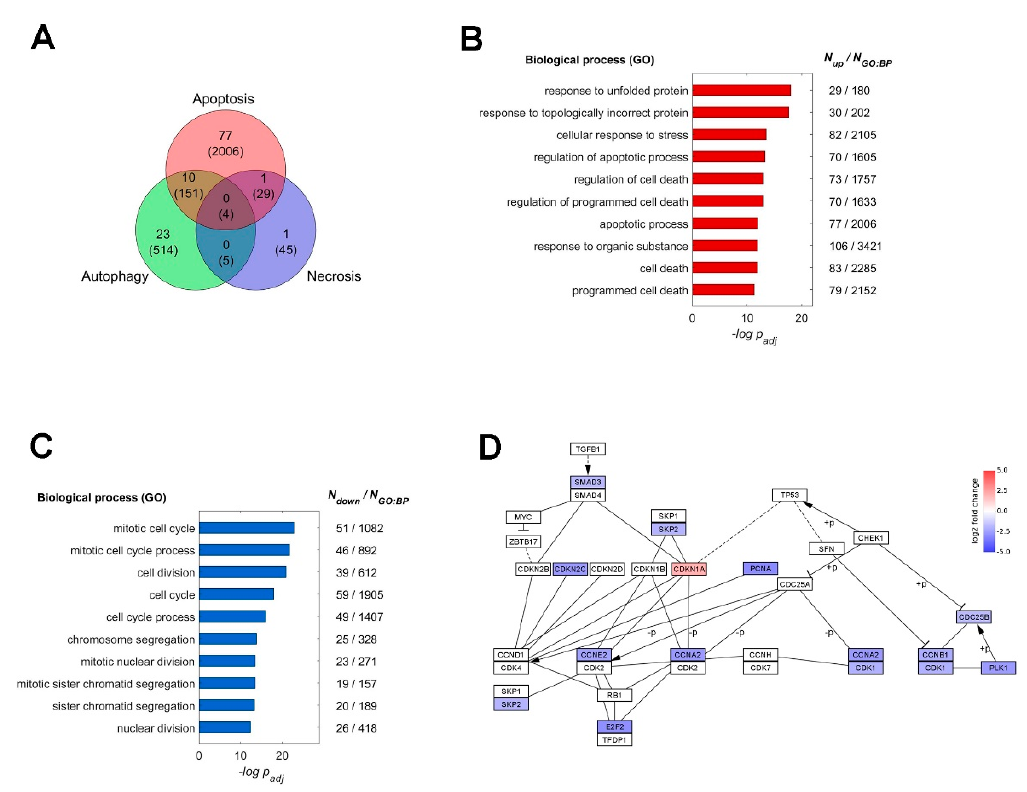
Figure 9. The altered expression profile upon the CD treatment. ( A ) The number of up-regulated genes are depicted in the Venn diagram showing their roles in types of programmed cell death. The intersection areas indicate the number of genes participating in multiple processes. The total number of genes in each category is indicated in parentheses. The top 10 enriched GO biological processes from the up-regulated ( B ) and down-regulated ( C ) genes and with the adjusted p -values are plotted on a negative logarithmic scale. The number of up-regulated genes and the total number in each process are also shown on the right of the plot. ( D ) The KEGG pathway of cell cycle progress. Genes with altered expression are color-coded for the log2 fold changes (red: up-regulated; blue: down-regulated; + p phosphorylation; − p dephosphorylation). The KEGG pathway map was acquired from Kyoto Encyclopedia of Genes and Genomes (https://www.genome.jp/kegg/) and the plot was performed by Cytoscape.